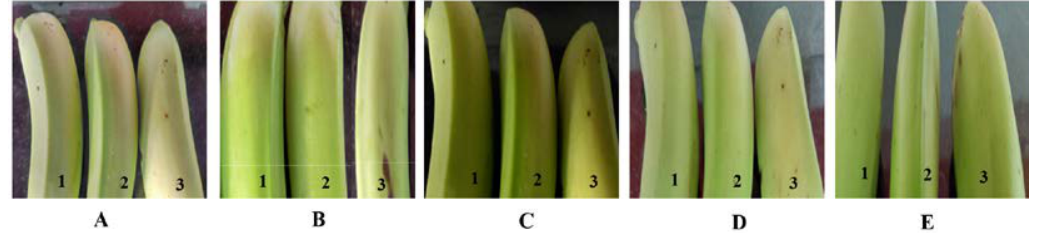
Fig.. 3.1. 0 th day of banana sample treated with different treatment A. Sodium alginate B. Starch C. Aloe vera D. Gelatin E. Glycerol